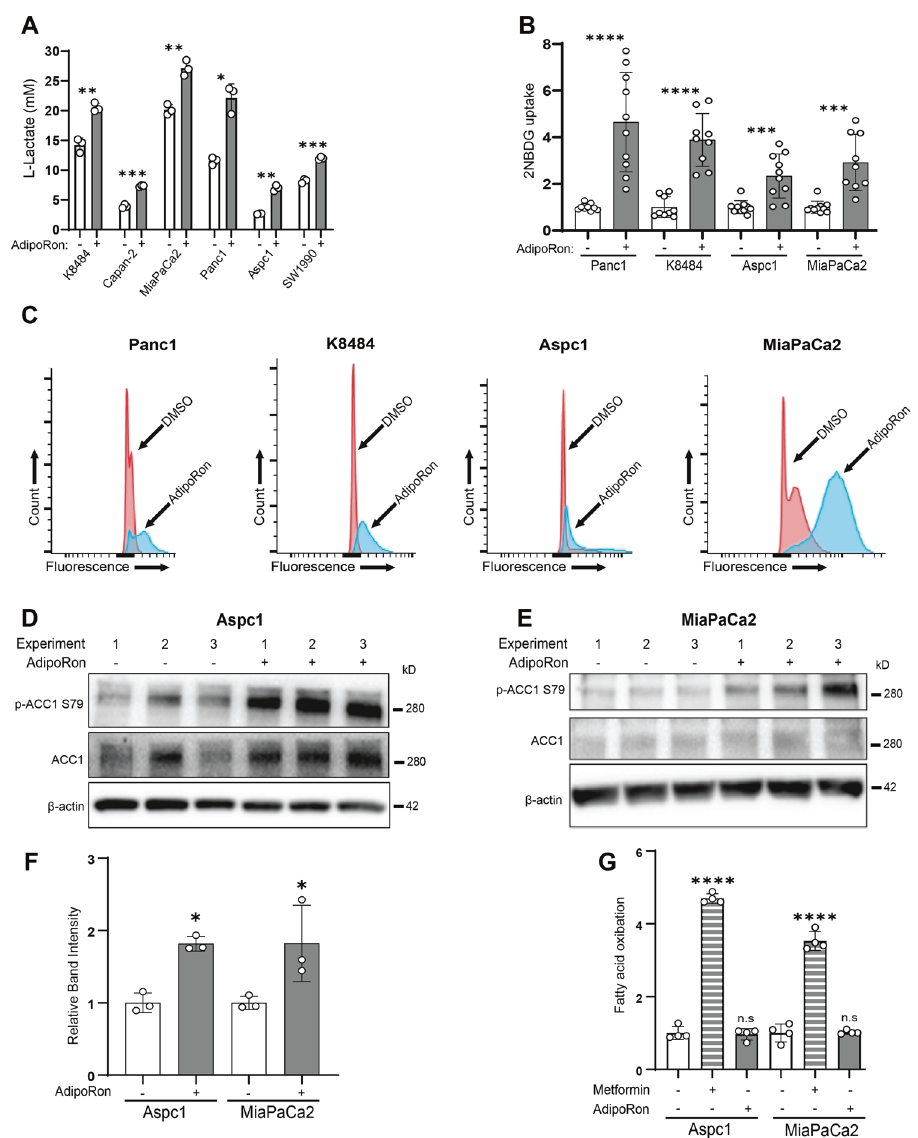
AdipoRon for 48 h, and then glucose- and serum-starved for 40 min prior to incubation with 2NBDG (200 µM) for 80 min. At the endpoints, the cells were washed and assessed for 2NBDG content either by plate reading (excitation 475 nm, emission 550 nm) or fl ow-cytometric analysis ( B , n = 10; C , n = 4). D – F Levels of phospho-ACC1 were assessed in response to AdipoRon treatment (6 h), blots were cropped, and levels adjusted for clarity ( n = 3). G Fatty acid oxidation was measured following AdipoRon treatment (6 h), n = 4. Statistics: t -test ( F ) or one-way ANOVA ( G ); error bars, SD; * P <